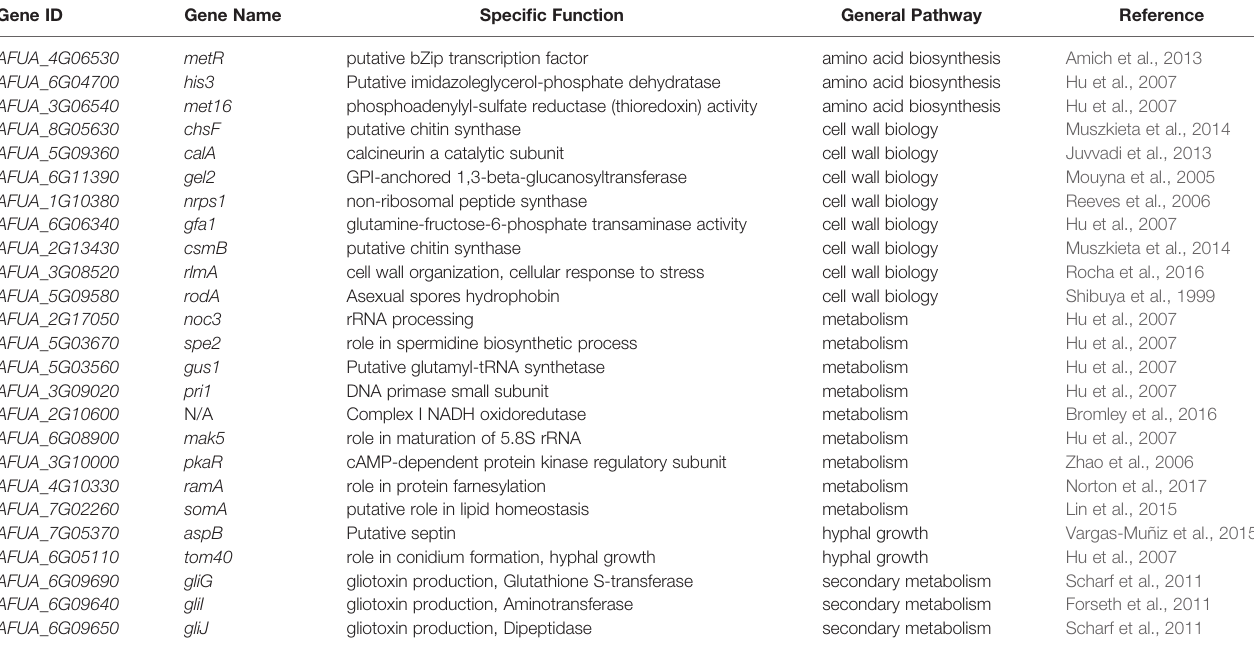
TABLE 1 | Twenty- fi ve genetic determinants of A. fumigatus virulence have a different evolutionary rate in their non-coding regions. Gene